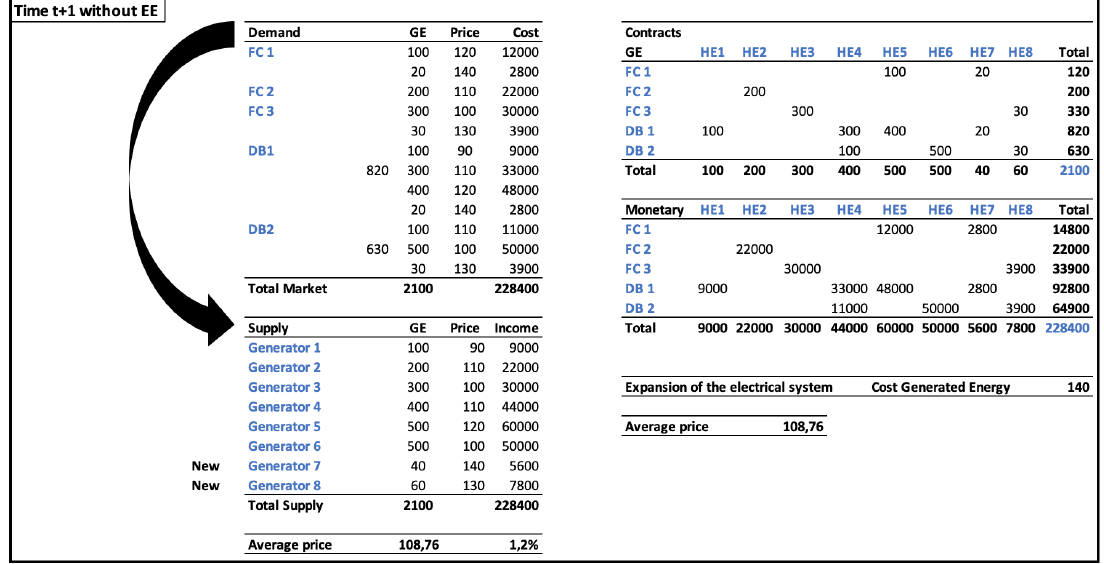
Figure 4. Details of the transition from time t to time t +